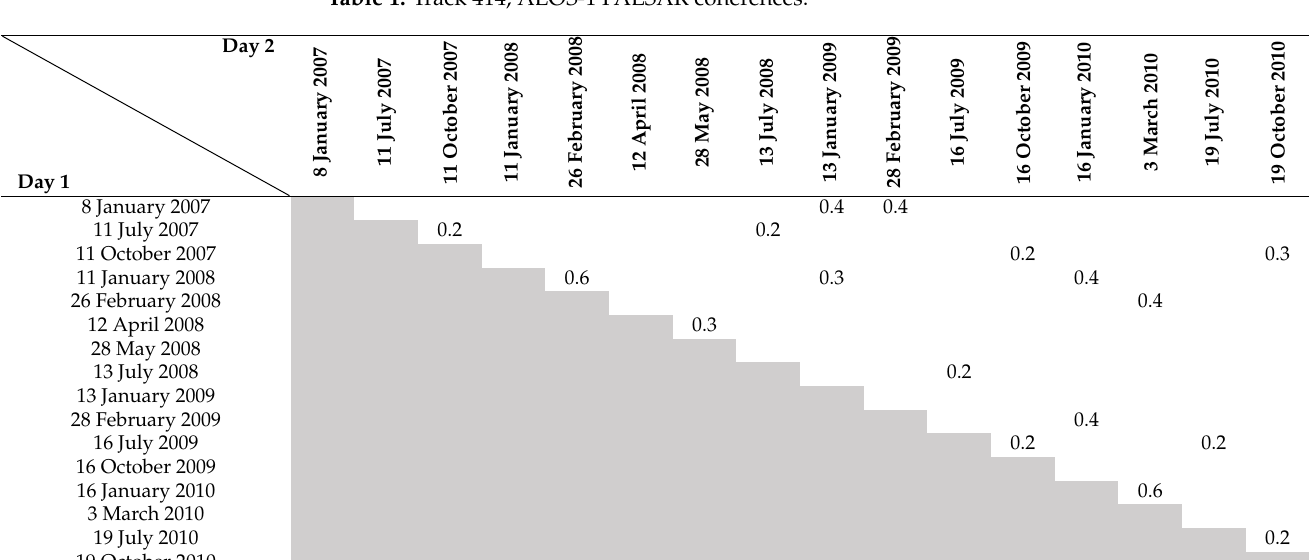
Table 1. Track 414, ALOS-1 PALSAR coherences.